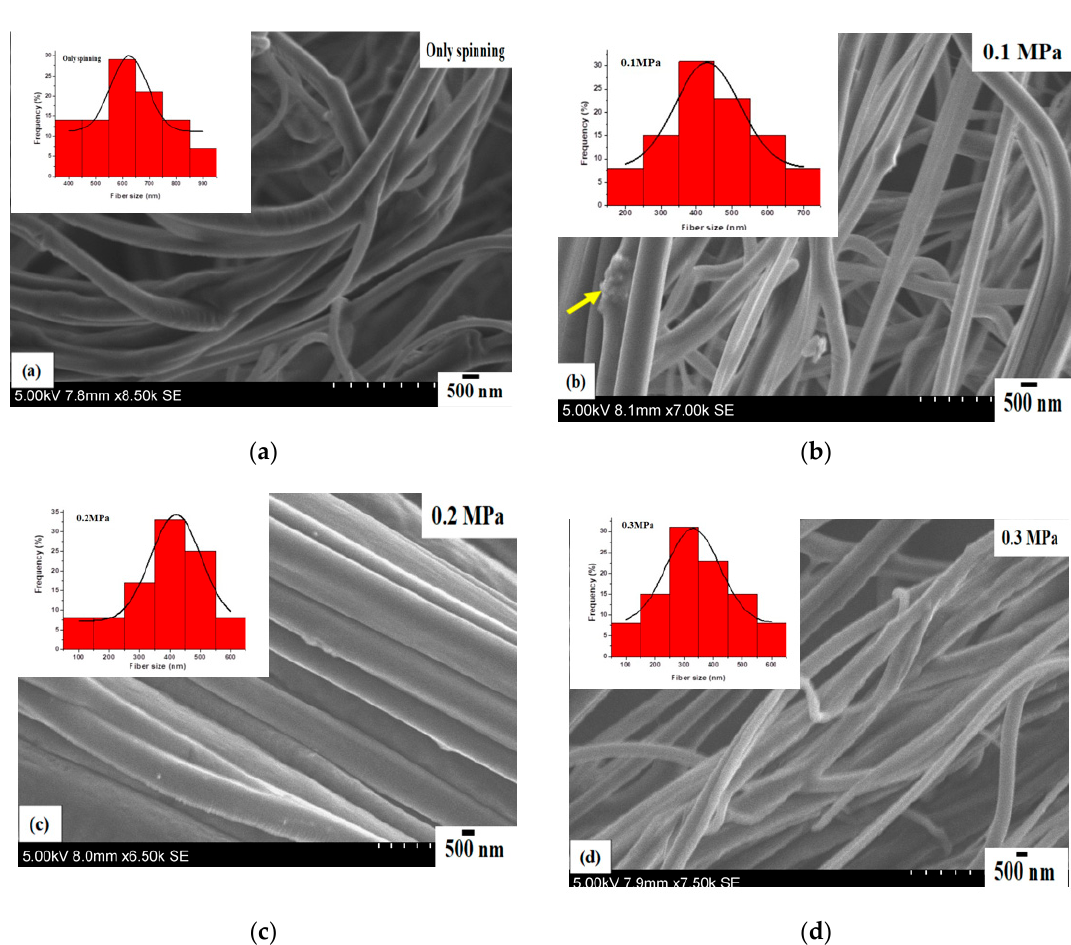
Figure 3. Scanning electron micrographs of core–sheath nanofibers obtained at a constant rotating speed 6000 RPM and different working pressures (MPa) ( a ) spinning only ( b ) 0.1 ( c ) 0.2 ( d ) 0.3. Insets show the corresponding fibre size distributions of core–sheath nanofibers for each case.